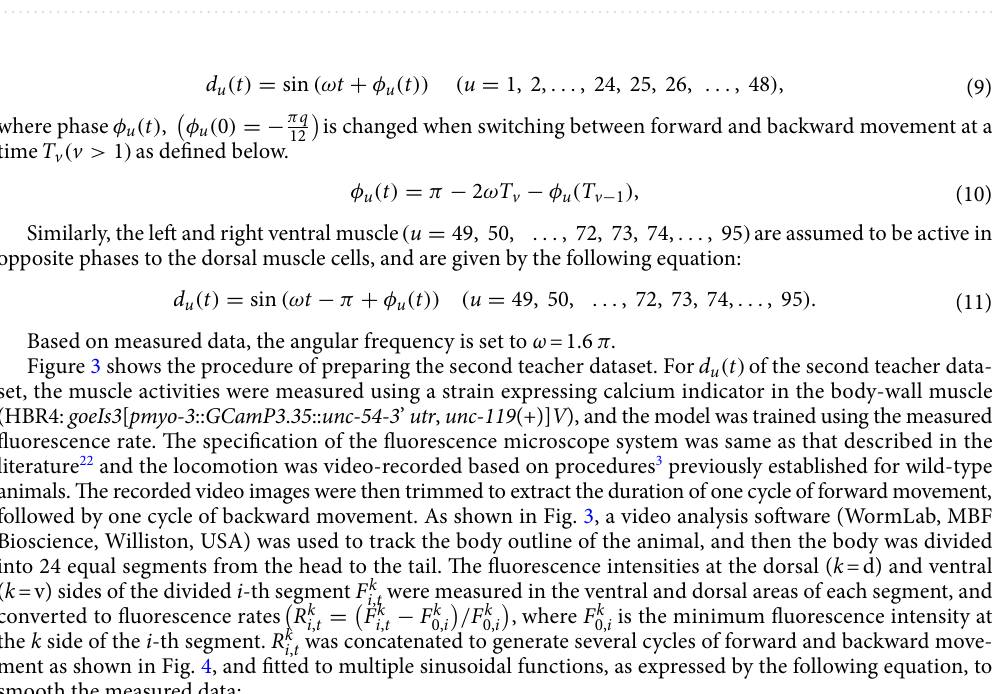
Figure 2. Motion analysis of C. elegans. ( A ) Motion analysis capture of C. elegans using the image analysis software Wriggle tracker (Library Inc., Tokyo). ( B ) Points tracked by the image analysis software. ( C ) Temporal change in the angles between the straight lines connecting adjacent